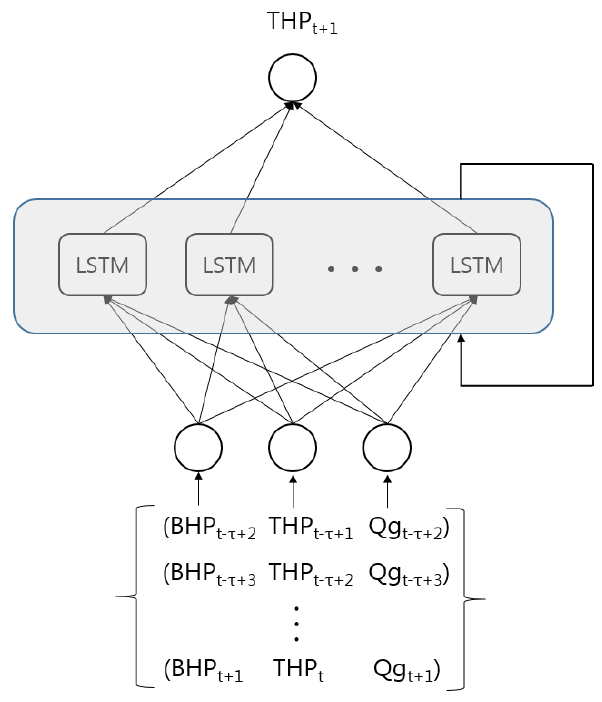
Figure 6. Example of the RNN-LSTM models in this study.